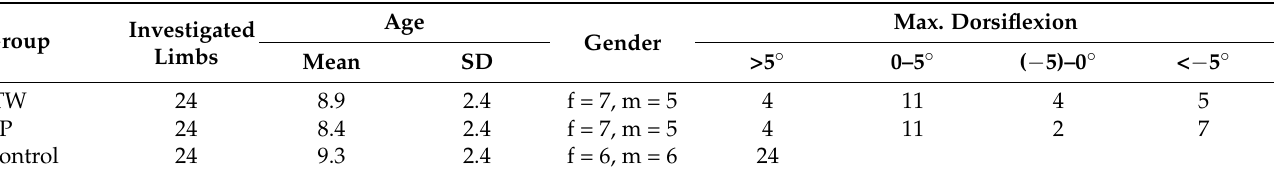
Table 1. Description of study